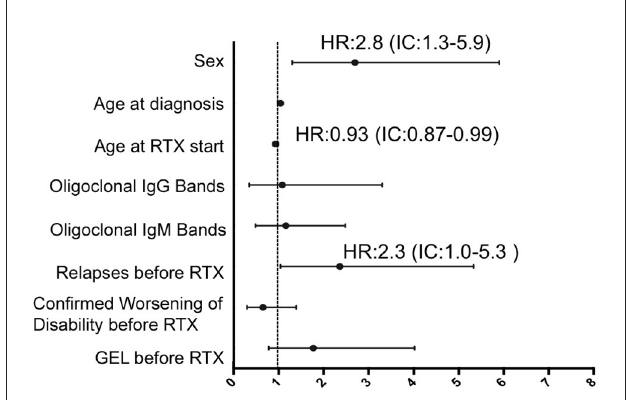
FIGURE5 Multivariate Cox regression for predictive variables of time to confirmed worsening of disability in progressive multiple sclerosis patients. Male sex, a younger age at baseline, and absence of previous relapses were the variables associated with reaching CWD status in this subgroup. CWD, confirmed worsening of disability; GEL, gadolinium-enhanced lesions; RTX,